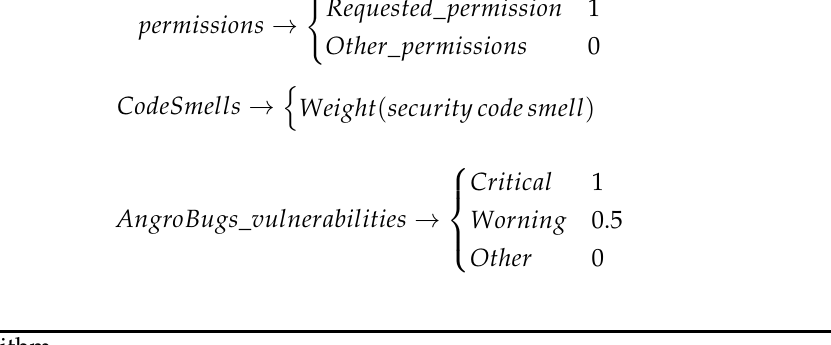
Algorithm 2: Feature Extraction